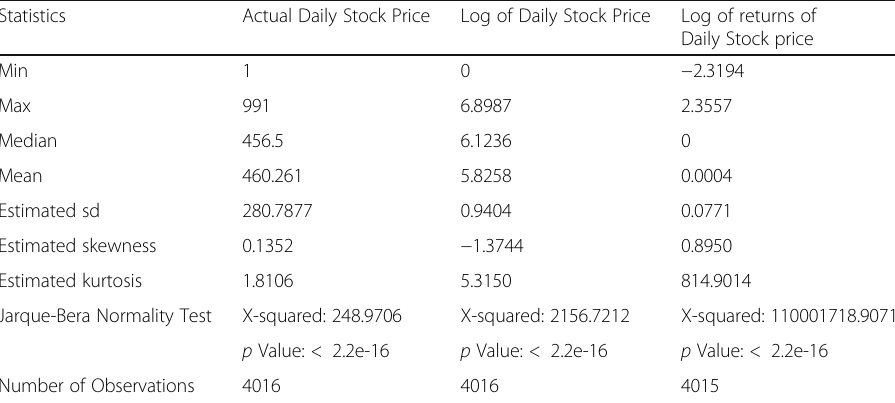
Table 1 Summary statistics, daily stock price and returns of Total Nigeria